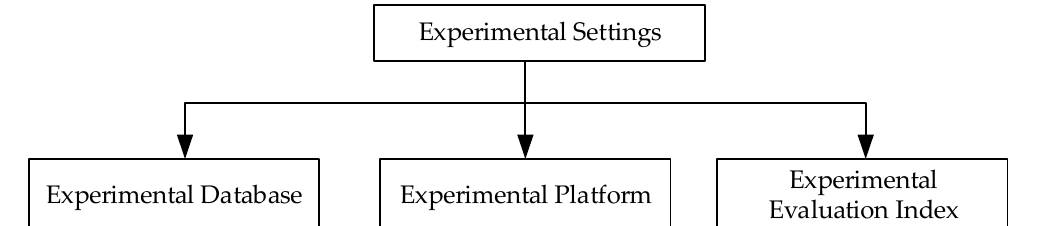
Figure 7. Flow diagram of experimental settings.